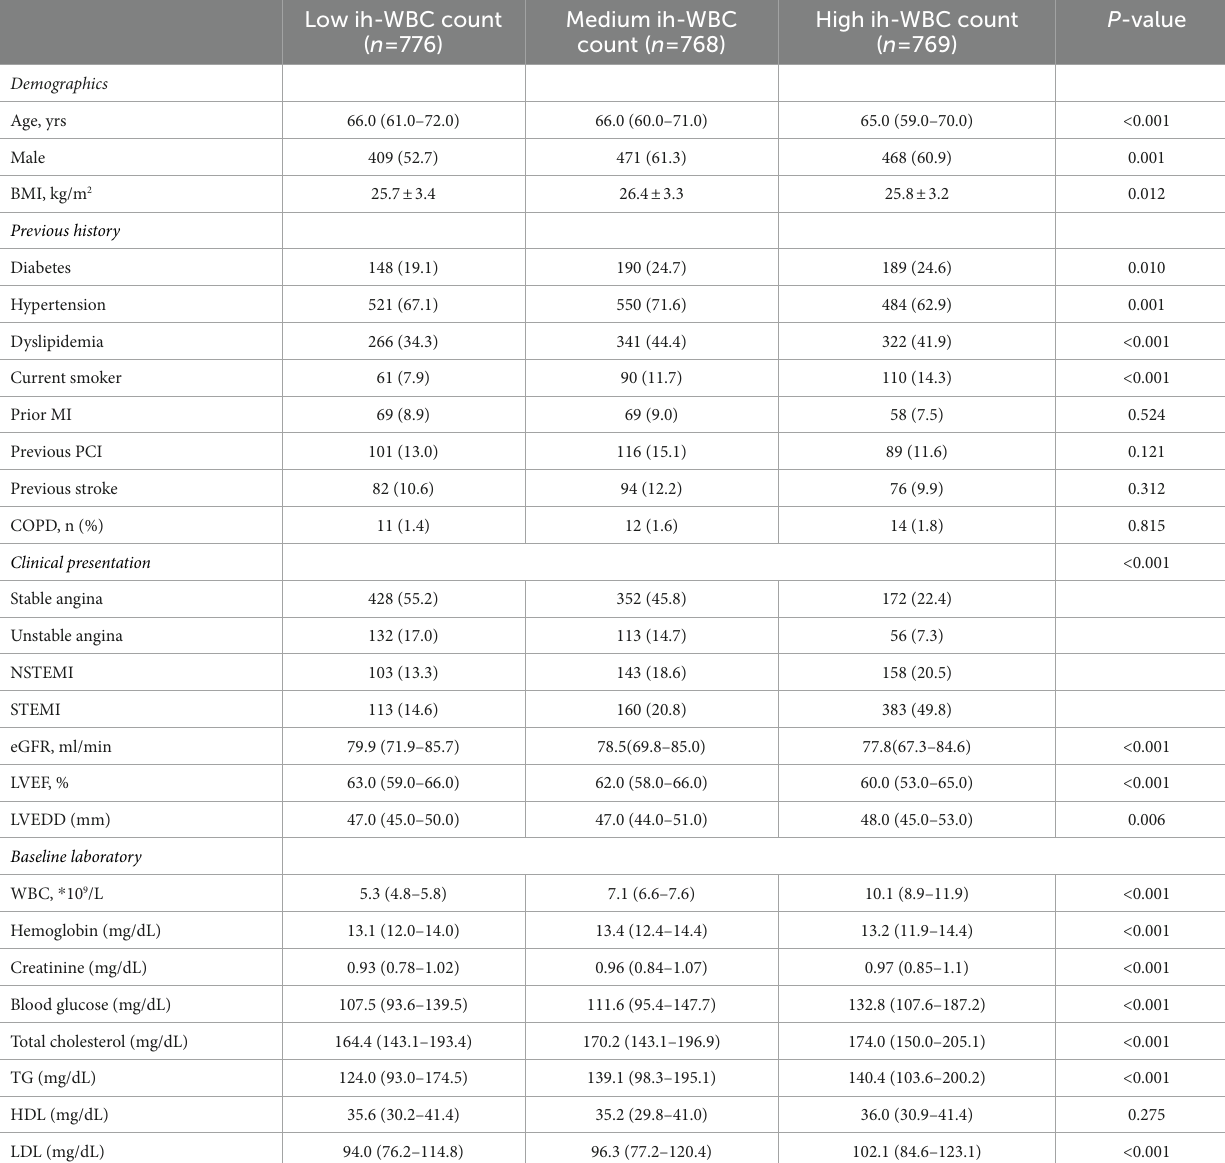
TABLE 1 Baseline clinical characteristics of